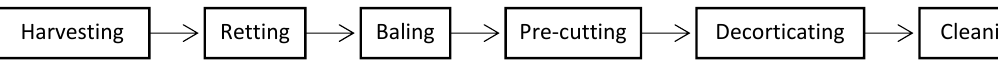
Figure 1. Processing scheme of hemp stems.